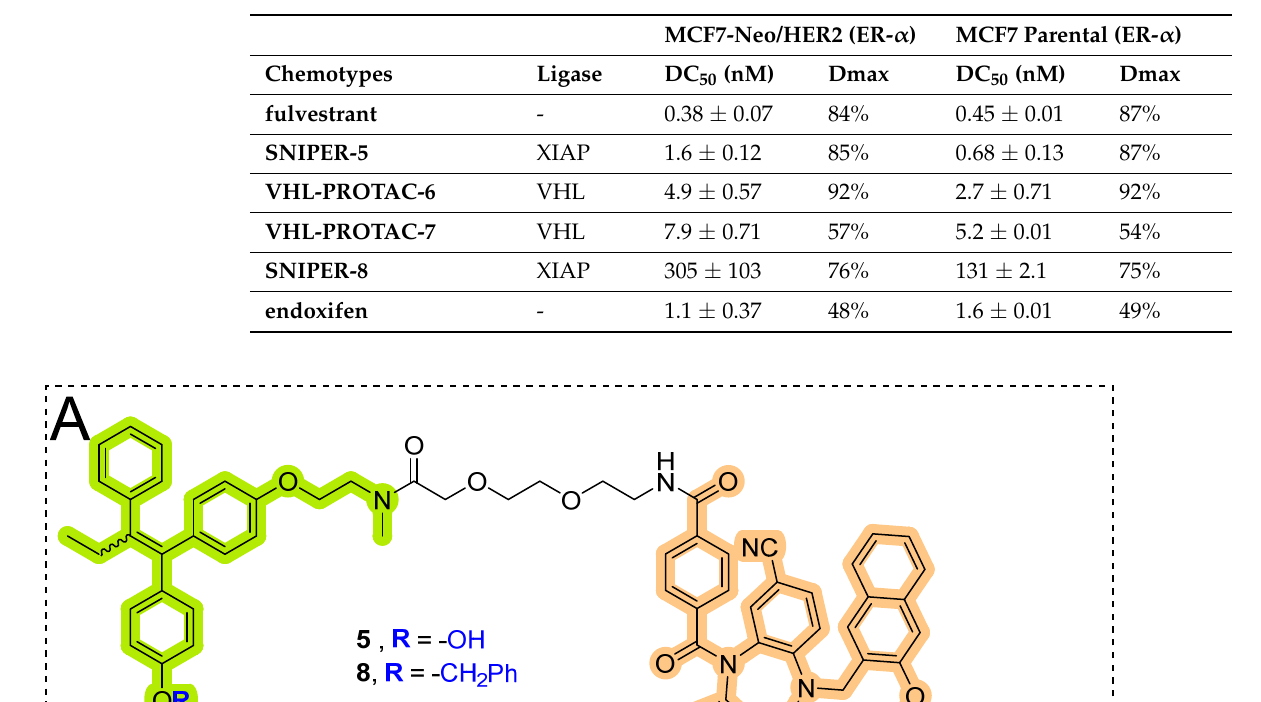
Table 3. PROTAC and SNIPER used for Antibody Drug Conjugates. Reproduced with permission from Dragovich et al. [143] Copyright 2020 Elsevier.